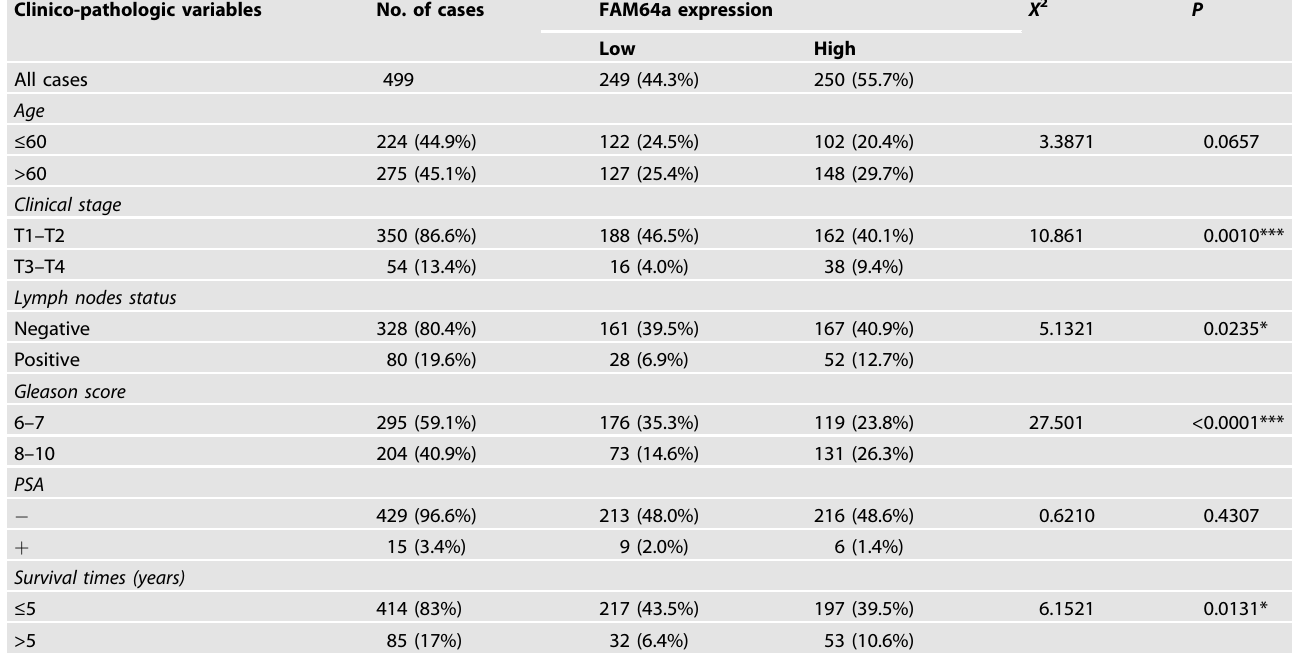
Table 2. Correlation between FAM64A expression and the clinicopathological characters of patients with prostate cancer (TCGA). Clinico-pathologic